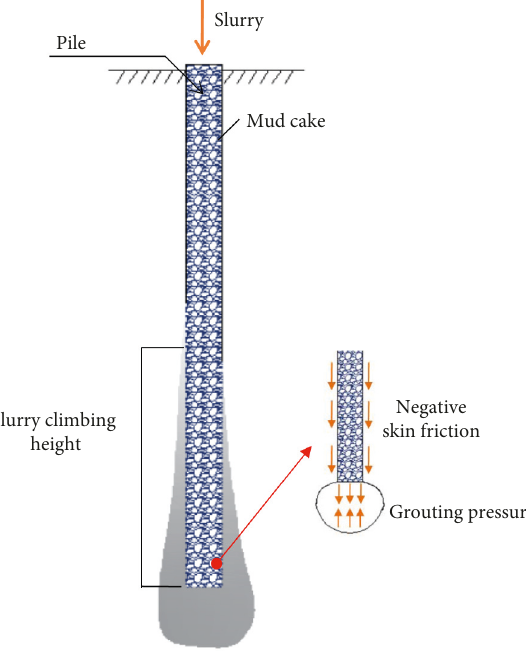
Figure 9: Schematic diagram of the postgrouting